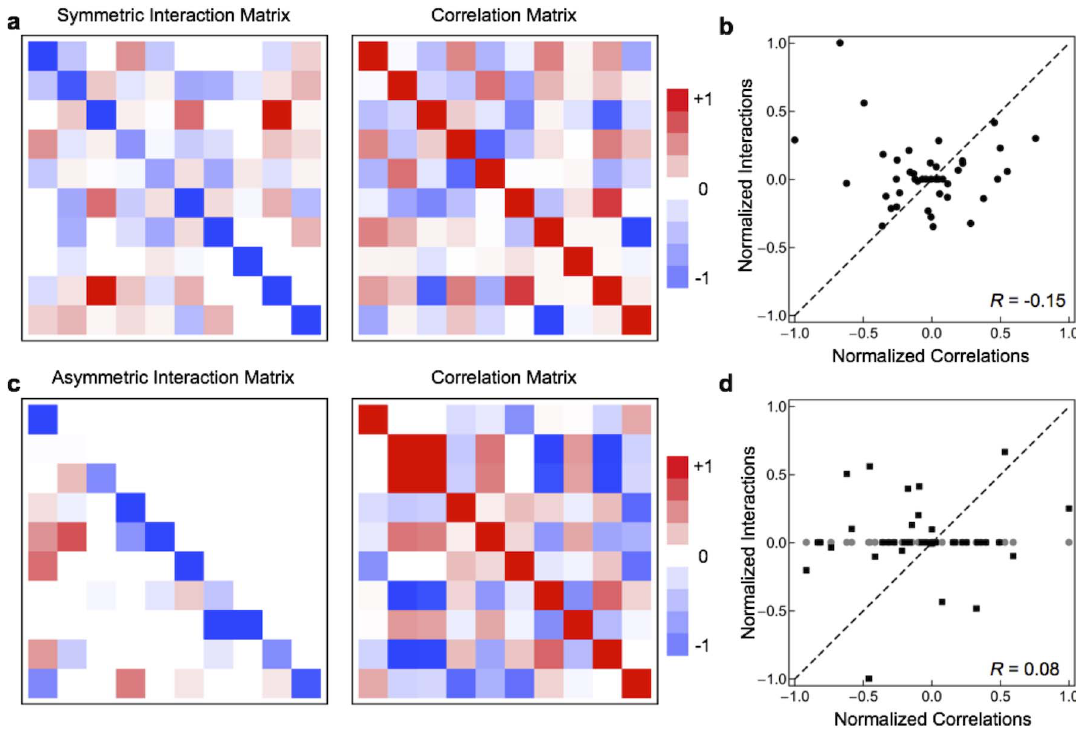
Figure 1. There is no simple relation between interaction coefficients and correlations in abundance. a) A symmetric interaction matrix and the corresponding correlation matrix. b) There is no relation between the interaction parameters and the correlations in abundance for the symmetric interaction matrix. c) An asymmetric interaction matrix and the corresponding correlation matrix. d) There is no relation between the interaction parameters and the correlations in abundance for the asymmetric interaction matrix. Points from above the diagonal in the interaction matrix are gray circles, whereas points from below the diagonal are black squares. In a and c, matrix elements have been scaled so that the smallest negative element is { 1 , the largest positive element is z 1 , and all elements retain their sign. In b and d, interaction coefficents were scaled so that the largest element by absolute value has D c ij D ~ 1 . (Fig. 2b,c) [18]. To bag forward stepwise regression, the data are randomly partitioned into a training set used for the regression and a test set used for evaluating the prediction error. The required